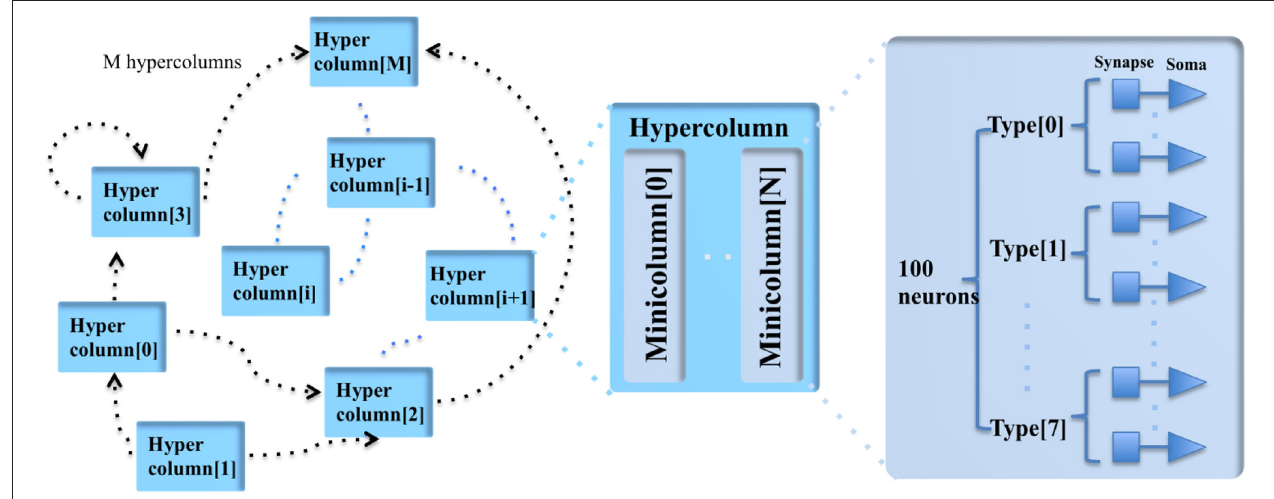
FIGURE 5 | The modular structure of the cortex emulator. The basic building block of the cortex emulator is the minicolumn, which consists of up to eight different types of heterogeneous neurons (100 in total). The functional building block is the hypercolumn, which can have up to 128 minicolumns. The connections are hierarchical: hypercolumn-level connections, minicolumn-level connections, and neuron-level connections.